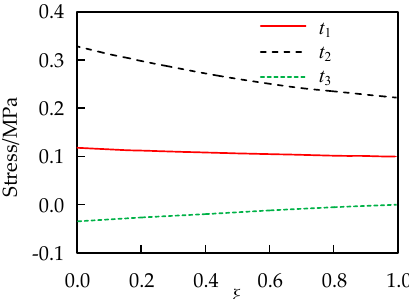
Figure 3. Exact solution of stresses of the cylinder.